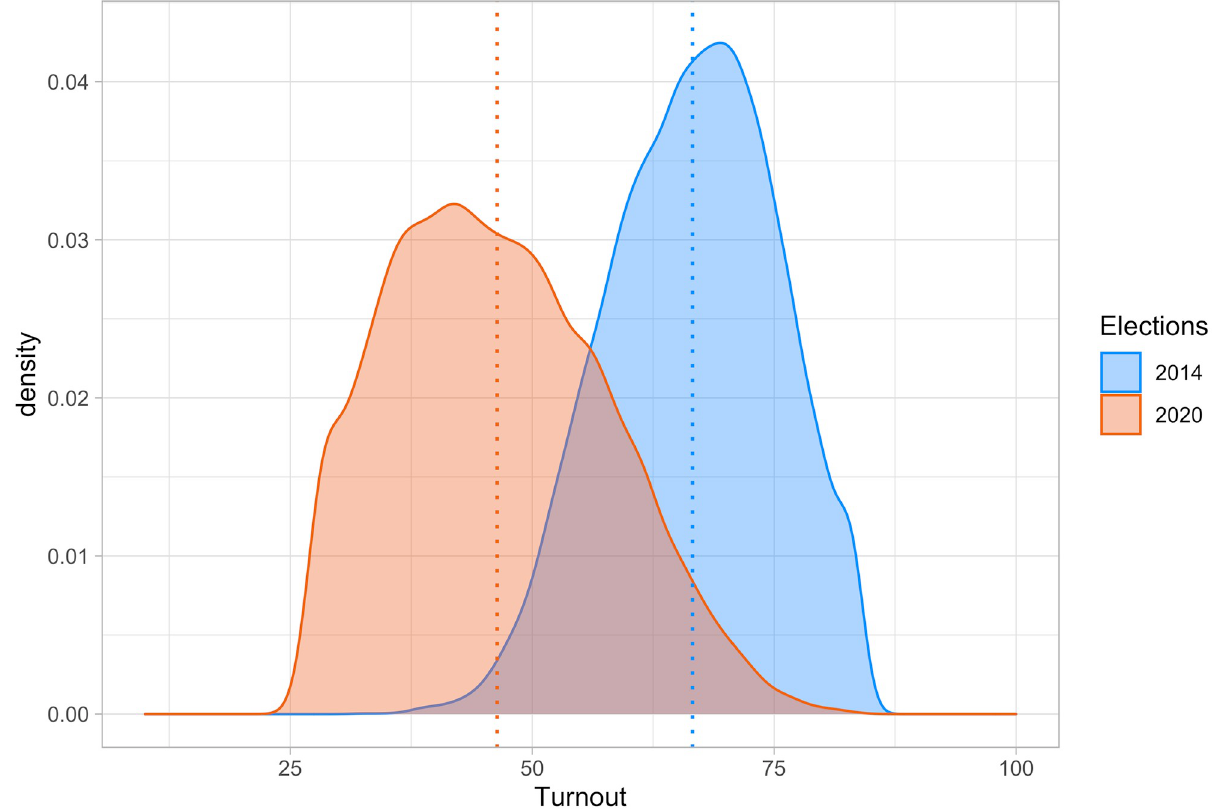
Fig 1. Distribution of turnout in the 2014 and 2020 French municipal